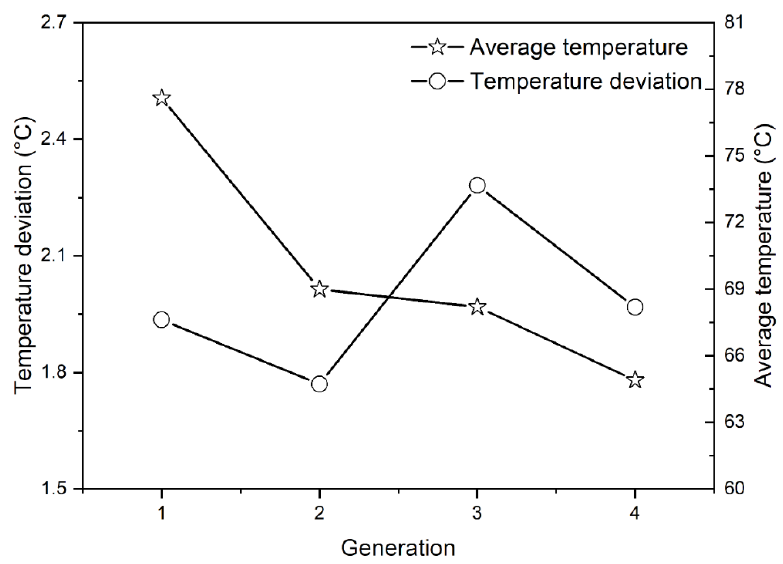
Figure 8. Standard deviation of temperature and average temperature change graph by genera- tion.